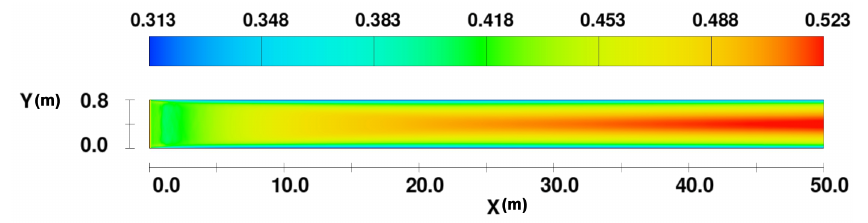
Figure 3. The profiles of x-velocity without a pier in X-Y at z = 12.75 cm and t = 400 s (unit: m/s).